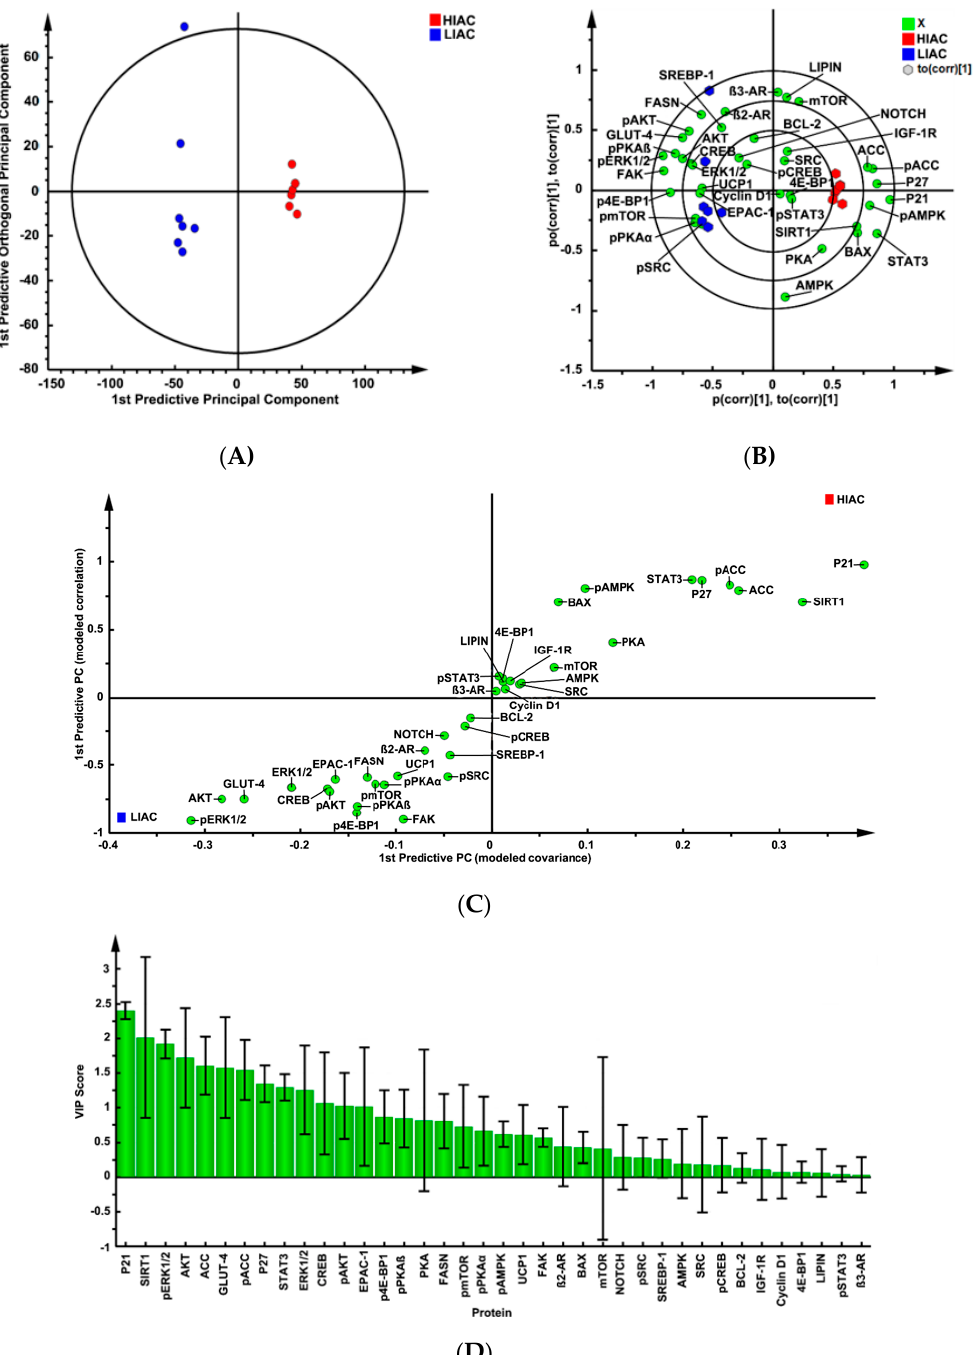
Figure 4. Analysis of protein expression in the mammary gland using a supervised clustering algorithm. Effects of high (HIAC) or low (LIAC) inherent aerobic running on patterns of protein expression in the mammary gland ( n = 7/group) were assessed by multivariate discriminant analysis. Initially, inherent clustering patterns were determined by unsupervised analysis through PCA and